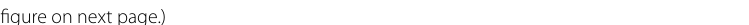
figure on next Fig. 1 a Location of the Okinawa Trough. The box denotes the area shown in Fig. 1b. b Locations of the hydrothermal fields in the Okinawa Trough (stars). Triangles indicate Quaternary volcanoes. Bathymetric contours are indicated every 200 m (thin lines) and 1000 m (thick lines). Dashed lines represent depth contours (100 and 200 km) in the Wadati‑Benioff zone (Letouzey and Kimura 1986; Pezzopane and Wesnousky 1989). Solid circles indicate the volcanic rock sampling sites: red for those in Shinjo et al. (1999), blue for those in Shinjo and Kato (2000), and yellow for those in this study. MOT and SOT represent the middle Okinawa Trough and southern Okinawa Trough, respectively. Boundaries between NOT and MOT and between MOT and SOT are indicated by light blue dashed